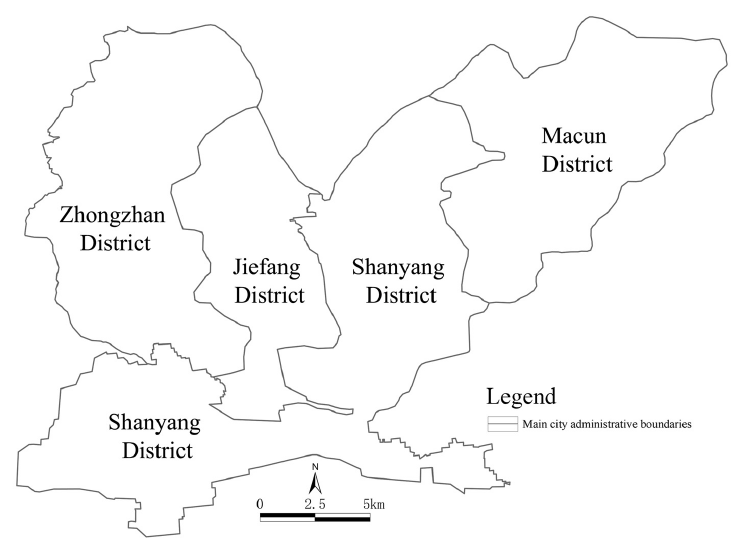
Figure 1. The main urban area in Jiaozuo, consisting of four districts.